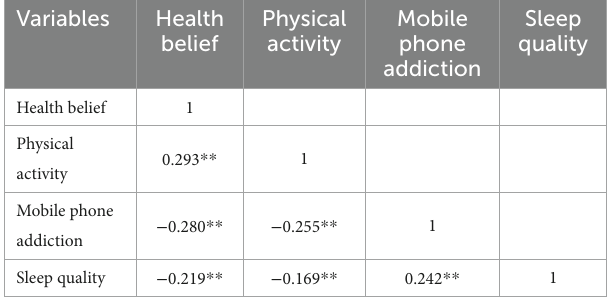
TABLE 2 The standard deviation, mean and correlation matrix of each variable.